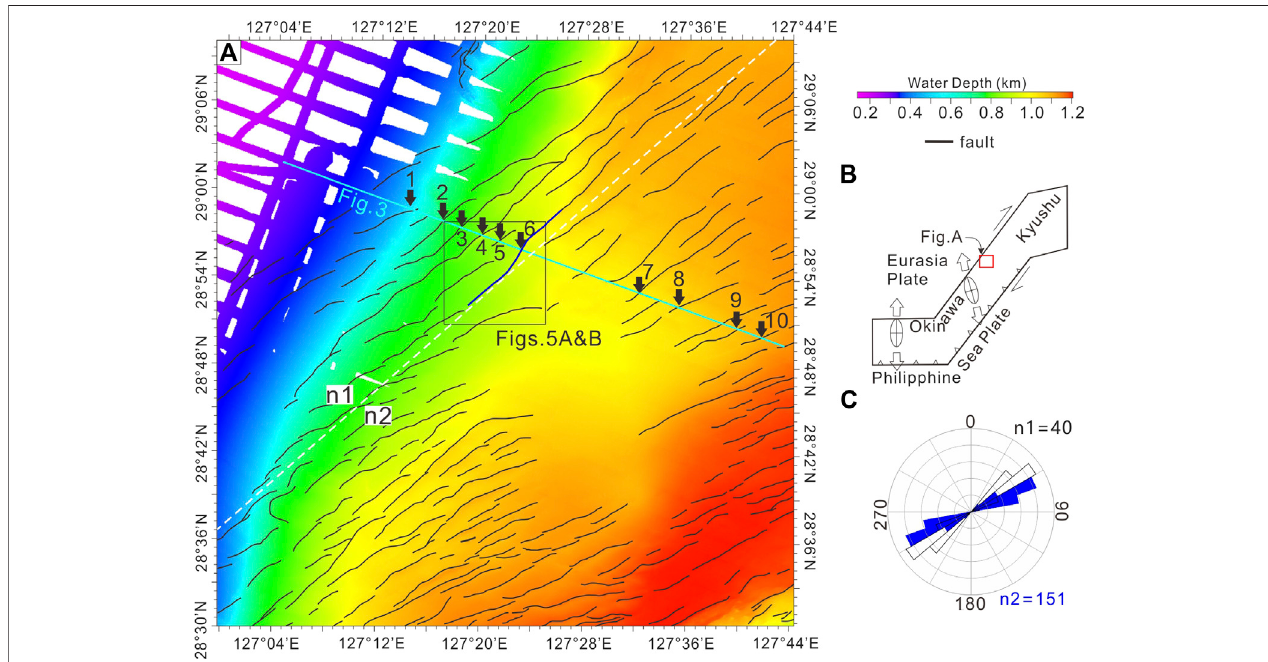
FIGURE 2 | (A) The bathymetric map showing the distribution of the fault scarps. It is mapped based on the MBES data. The blue line is the fault incorporated into the model. (B) Theschematic fi gure showingtheregionaltectonic setting and thedirectionofextension (hollow arrows) intheOkinawaTrough (fromFabbri et al.,2004). (C) Rose diagram showing the orientations of the fault groups (n1 and n2, bounded by the white dashed line in Fig. A ).